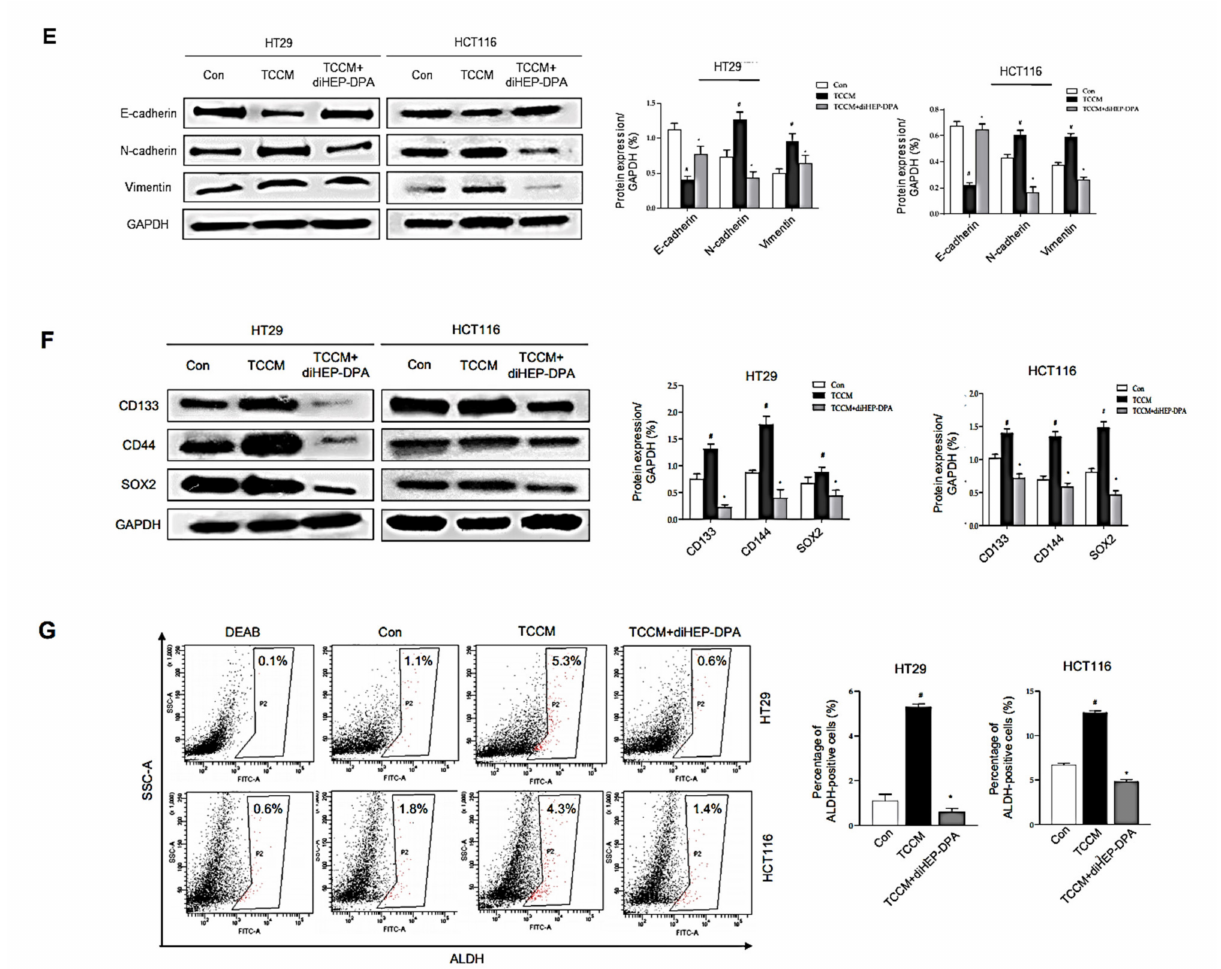
Figure 4. DiHEP-DPA affects the EMT process and stemness of colorectal cancer cells through modulation of TAM pola ization. ( A ) Decreased tumorspheres-formation efficiency (TFE) by TCCM-DPA treatment. Tumorspheres derived from HT29 and HCT116 cells were cultured for 7 d in the presence of TCCM, TCCM-DPA, or DMSO. ( B ) Migration of HT29 and HCT116 cells treated with TCCM or TCCM-DPA (RPMI-1640/0.5% FBS), determined by scratch assay. Scale bar: 100 µ m. ( C ) Cell migration (without Matrigel) and invasion (with Matrigel) of HT29 and HCT116 cells exposed to TCCM or TCCM-DPA, determined by Transwell assays. Scale bar: 100 µ m. ( D ) Transcript levels of the EMT markers, E-cadherin, N-cadherin, Vimentin in TCCM-treated HT29, and HCT116 cells, determined using gene-specific primers and quantitative RT-PCR. β -actin was detected as an internal reference. ( E , F ) Expression of EMT protein markers and cancer stemness markers (CD133, CD44, and Sox2), determined by Western blotting using the corresponding antibodies. ( G ) Decrease in the ALDH-positive cell population by treatment with TCCM-DPA. Colorectal cancer cells were treated with TCCM or TCCM-DPA for 48 h and analyzed by FACS. Data from triplicate experiments are presented as the means ± SD ( # p < 0.05 versus the DMSO-treated control group; * p < 0.05 versus the TCCM